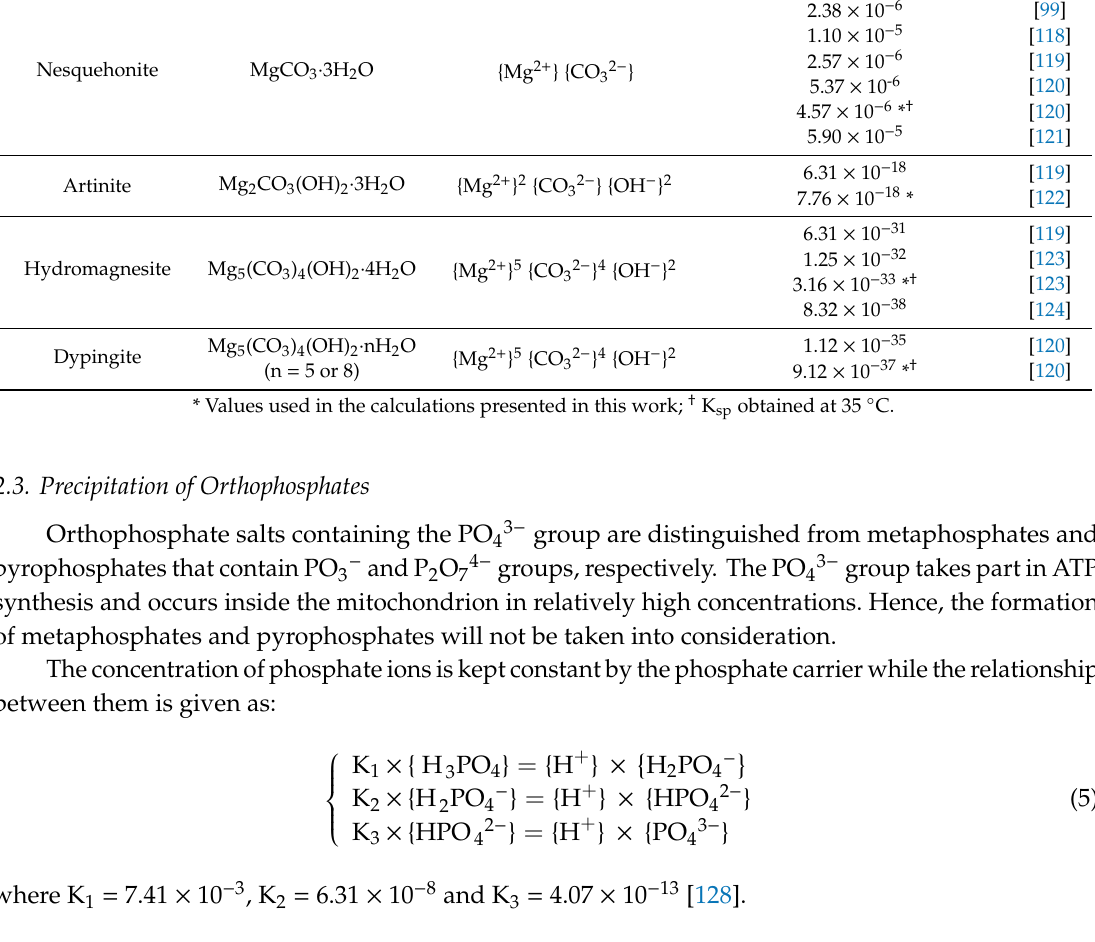
Table 3. The precipitation of insoluble magnesium carbonates. The activity products ( Q ) and the solubility products K sp (at 25 ◦ C) are obtained from the literature. Solubility Product, K sp at 25 Formula Activity Product ( Q ) ◦ C